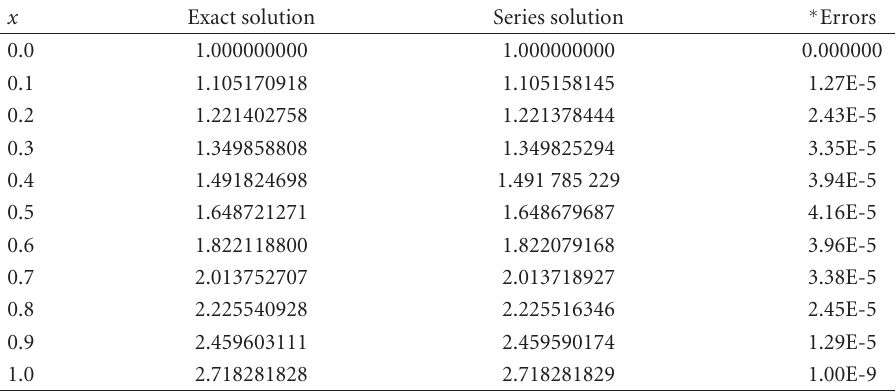
Table 5 . 1 . Error